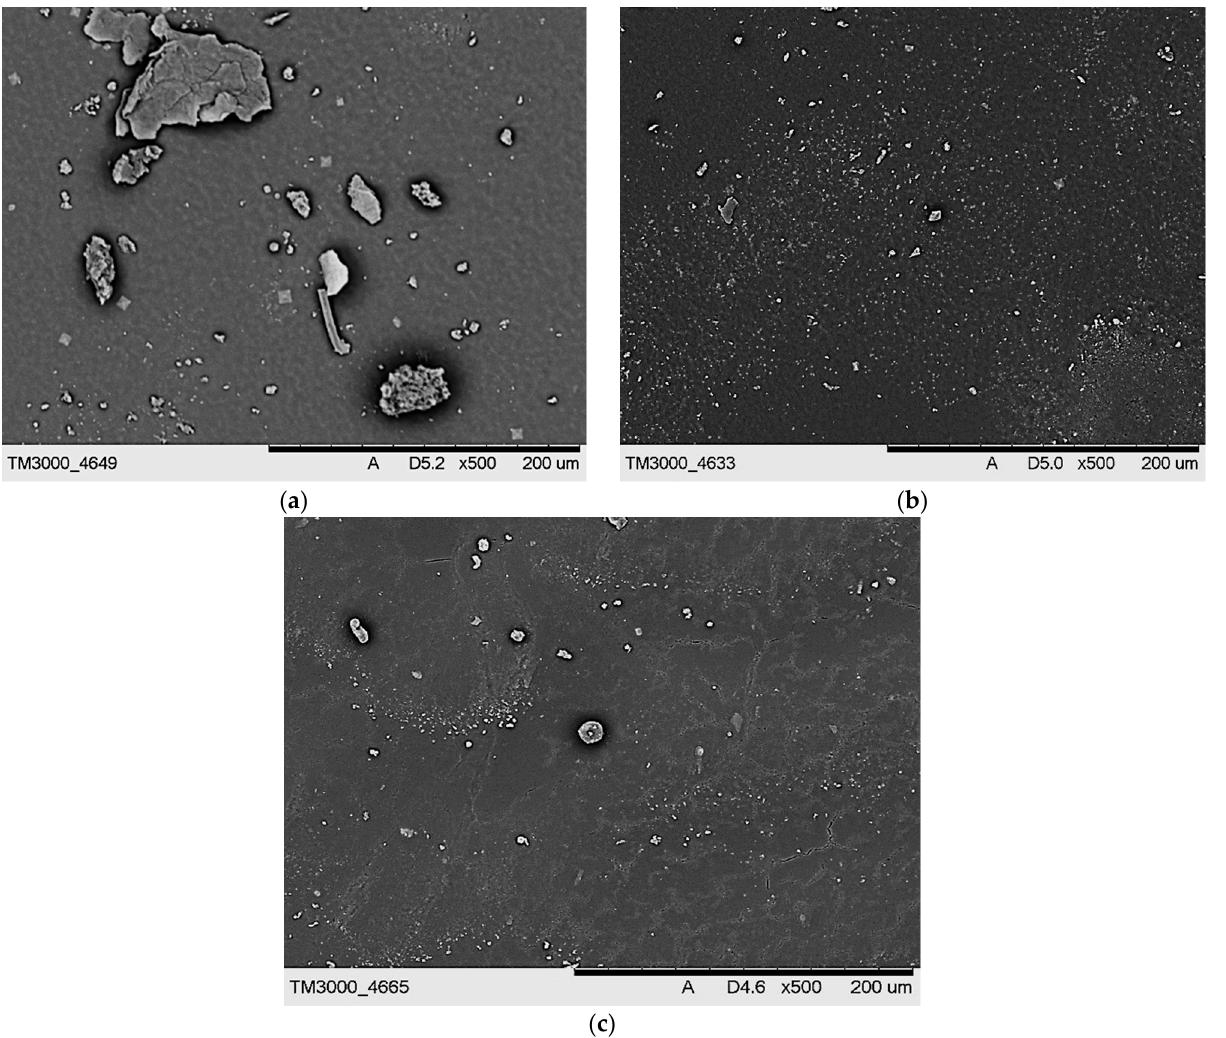
Figure 11. SEM images of hydrogel samples containing PEGDA 700: ( a ) 1.5 mL, ( b ) 2.0 mL, and ( c ) 2.5 mL.